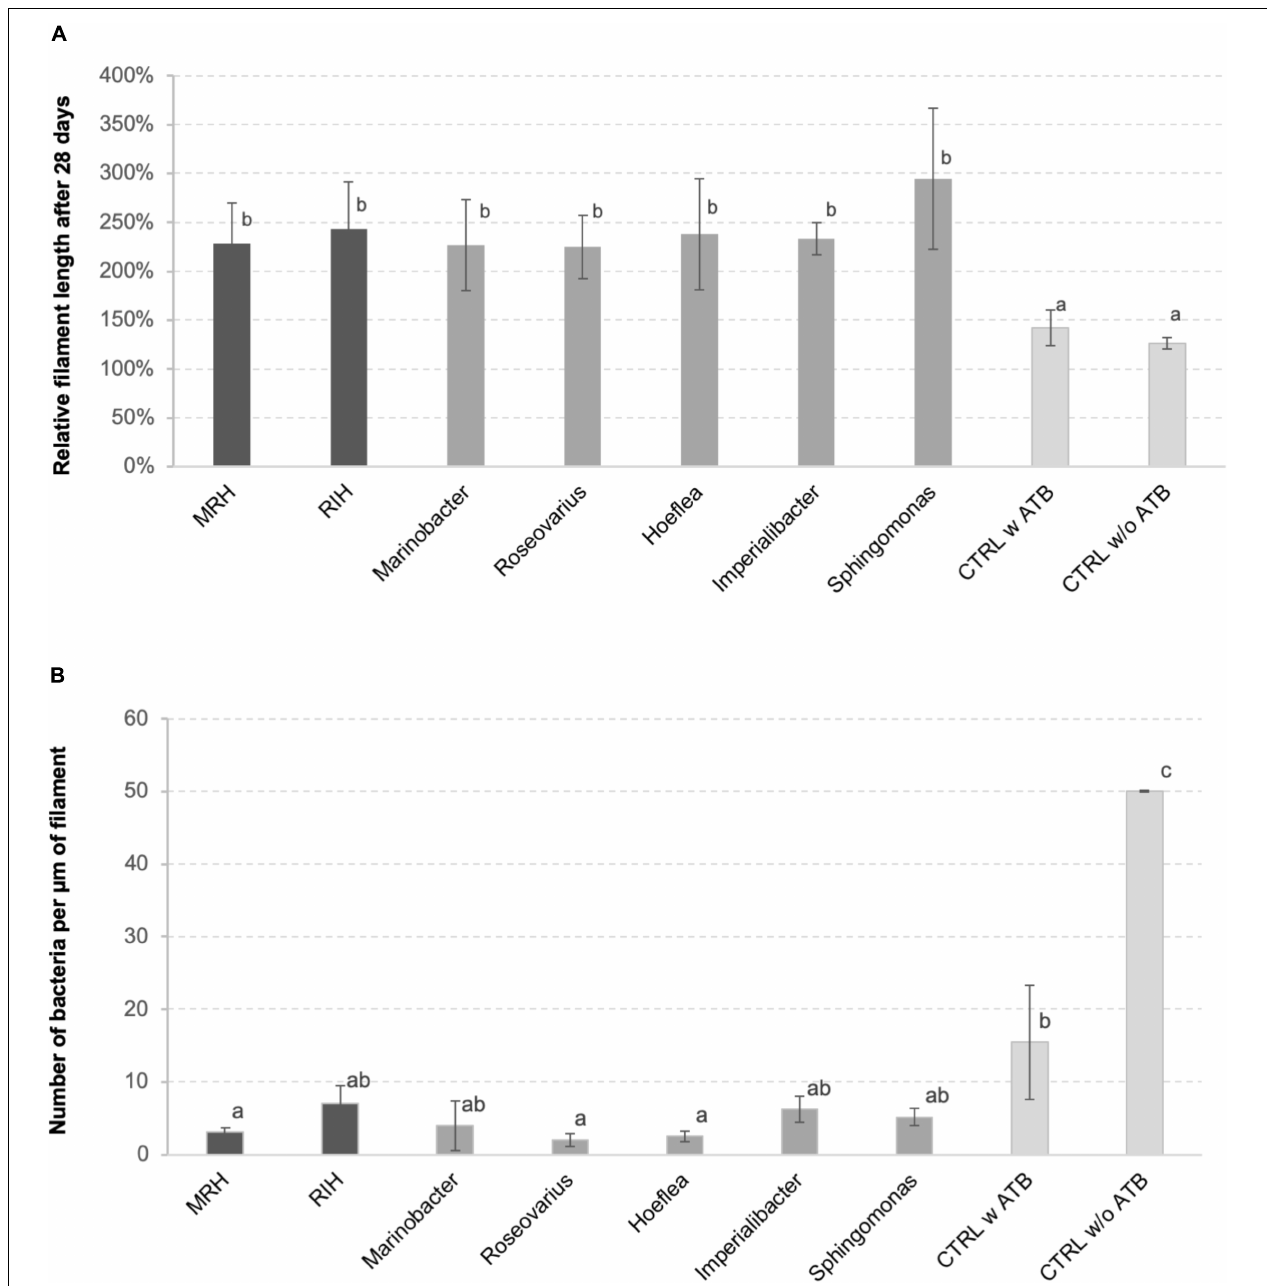
FIGURE 1 | (A) Relative length of E. siliculosus filaments after 28 days of (co-)culture compared to the starting point. (B) Number of bacteria detected on algal filaments after 28 days of co-culture. Both panels (A,B) show means of 3 replicate co-cultures ± SD and differences are statistically significant (one-way ANOVA p < 0.01). The letters above the columns indicate the results of a TUKEY HSD pairwise comparisons ( p < 0.05). CTRL, control; ATB, antibiotic treatment; MRH, Marinobacter – Roseovarius – Hoeflea ; RIH, Roseovarius – Imperialibacter – Hoeflea